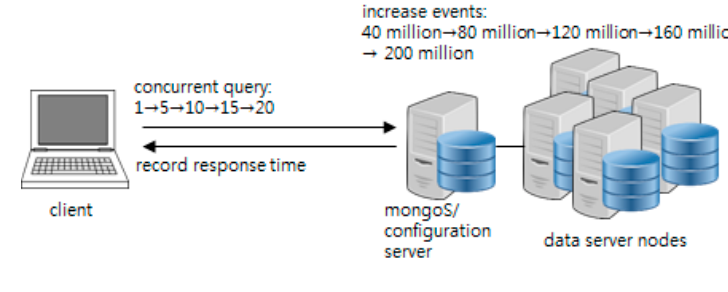
Figure 7. Test scenario.